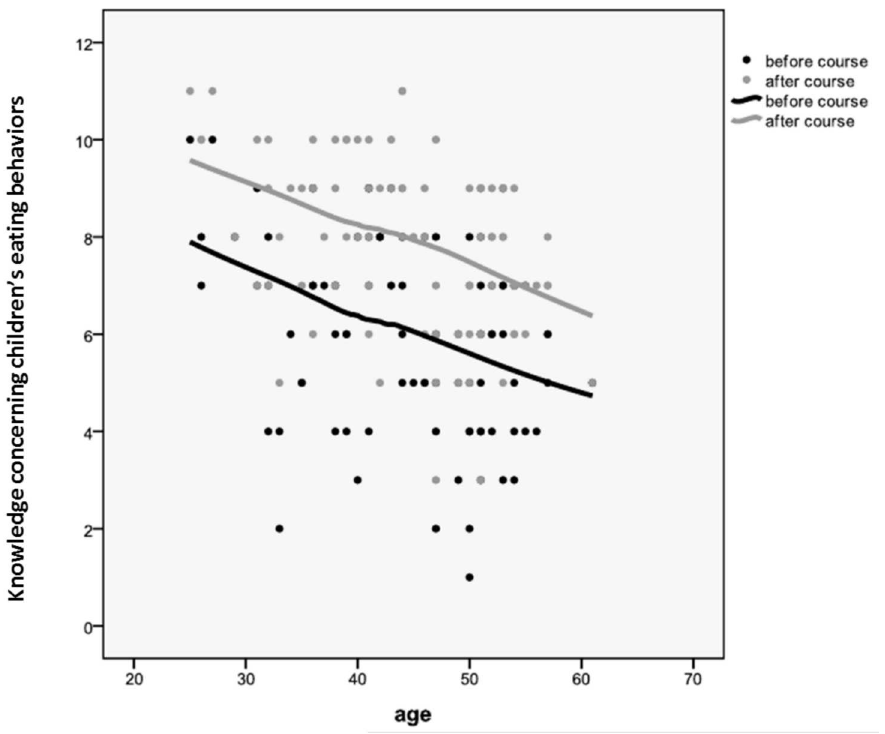
Figure 5b. Scatter plot for age and knowledge concerning children’s eating behaviors before and after the course (including LOESS fit